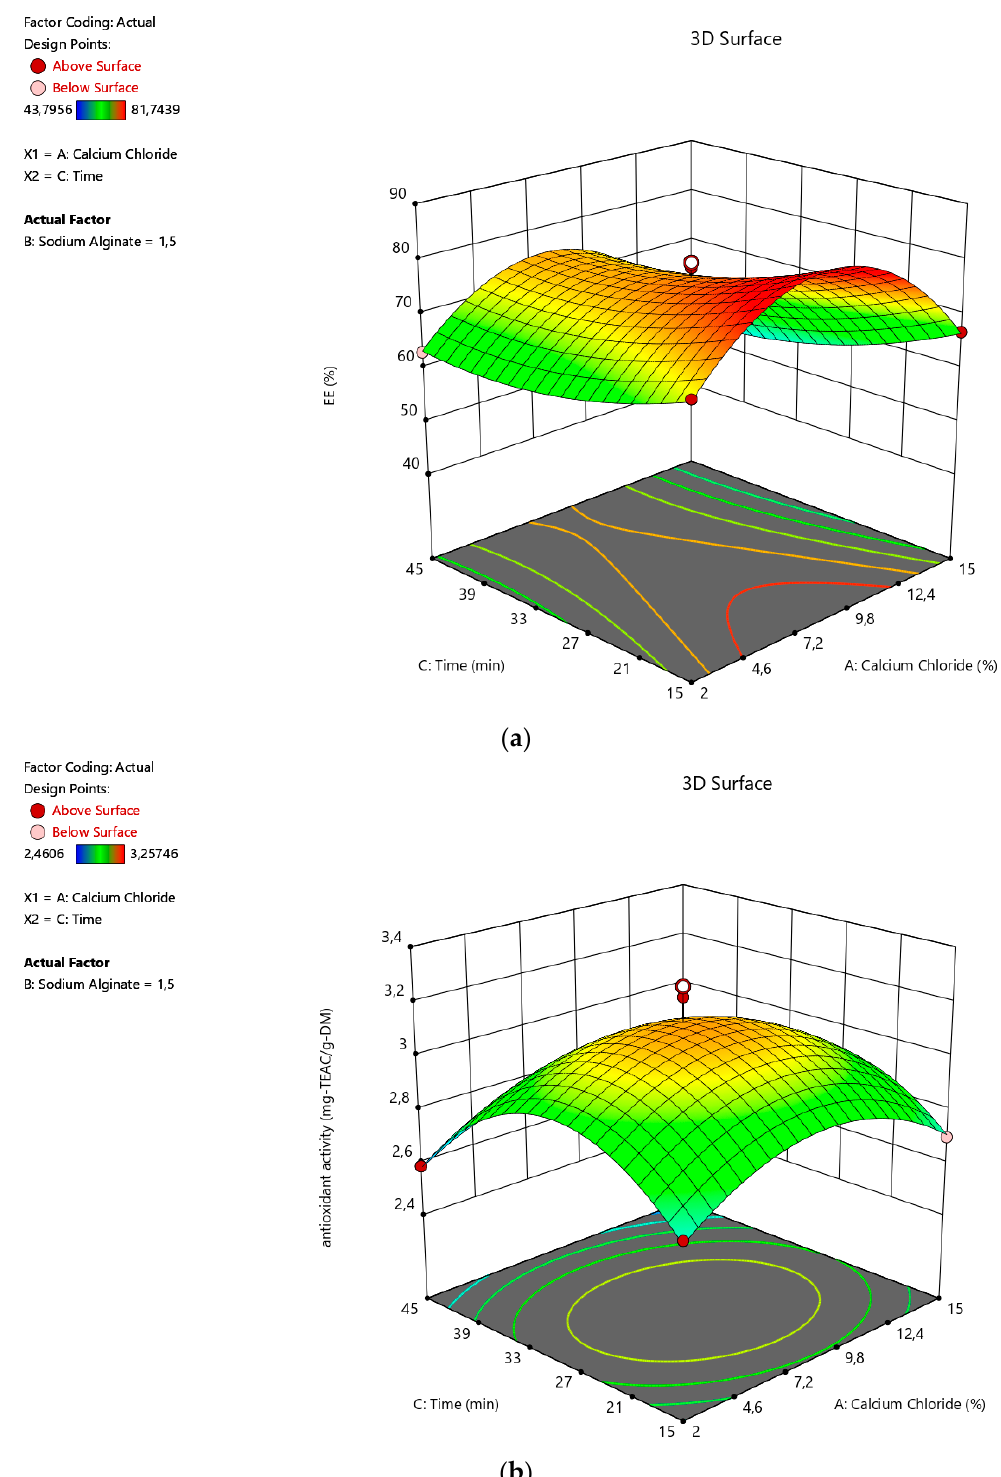
Figure 1. Effects of calcium chloride concentration to alginate concentration on the ( a ) encapsulation efficiency and ( b ) antioxidant activity of the alginate microcapsules containing the active substances from sour cherry peel extract.